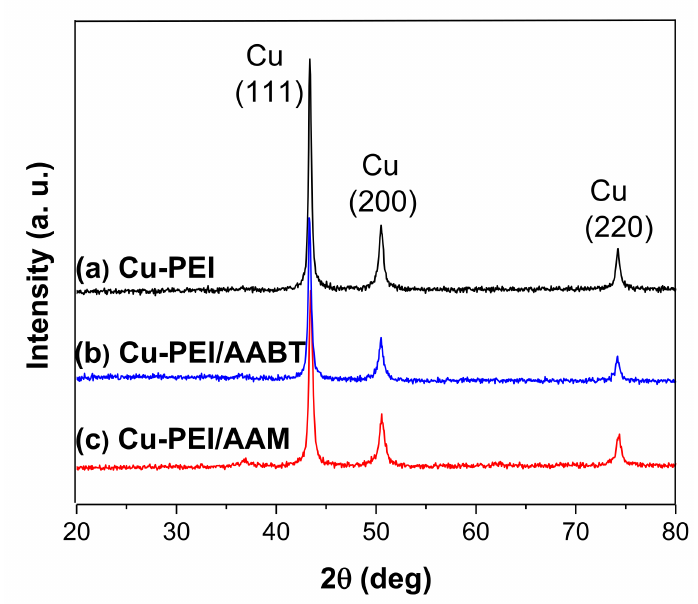
Figure 1. XRD diffractograms of Cu NPs synthesized with different stabilizers. ( a ) Cu-PEI NPs, ( b ) Cu-PEI/AABT NPs, and ( c ) Cu-PEI/AAM NPs.